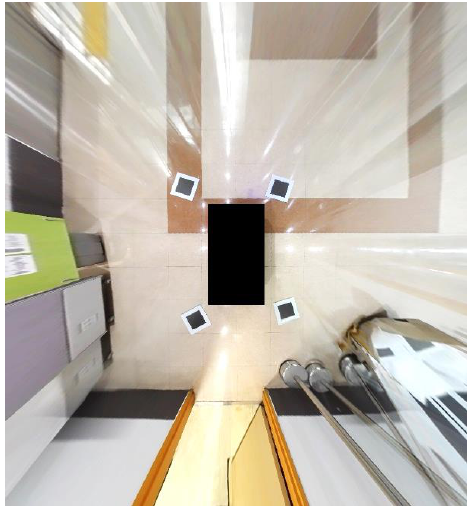
Figure 15. The results of the proposed method using an electric vehicle for children.